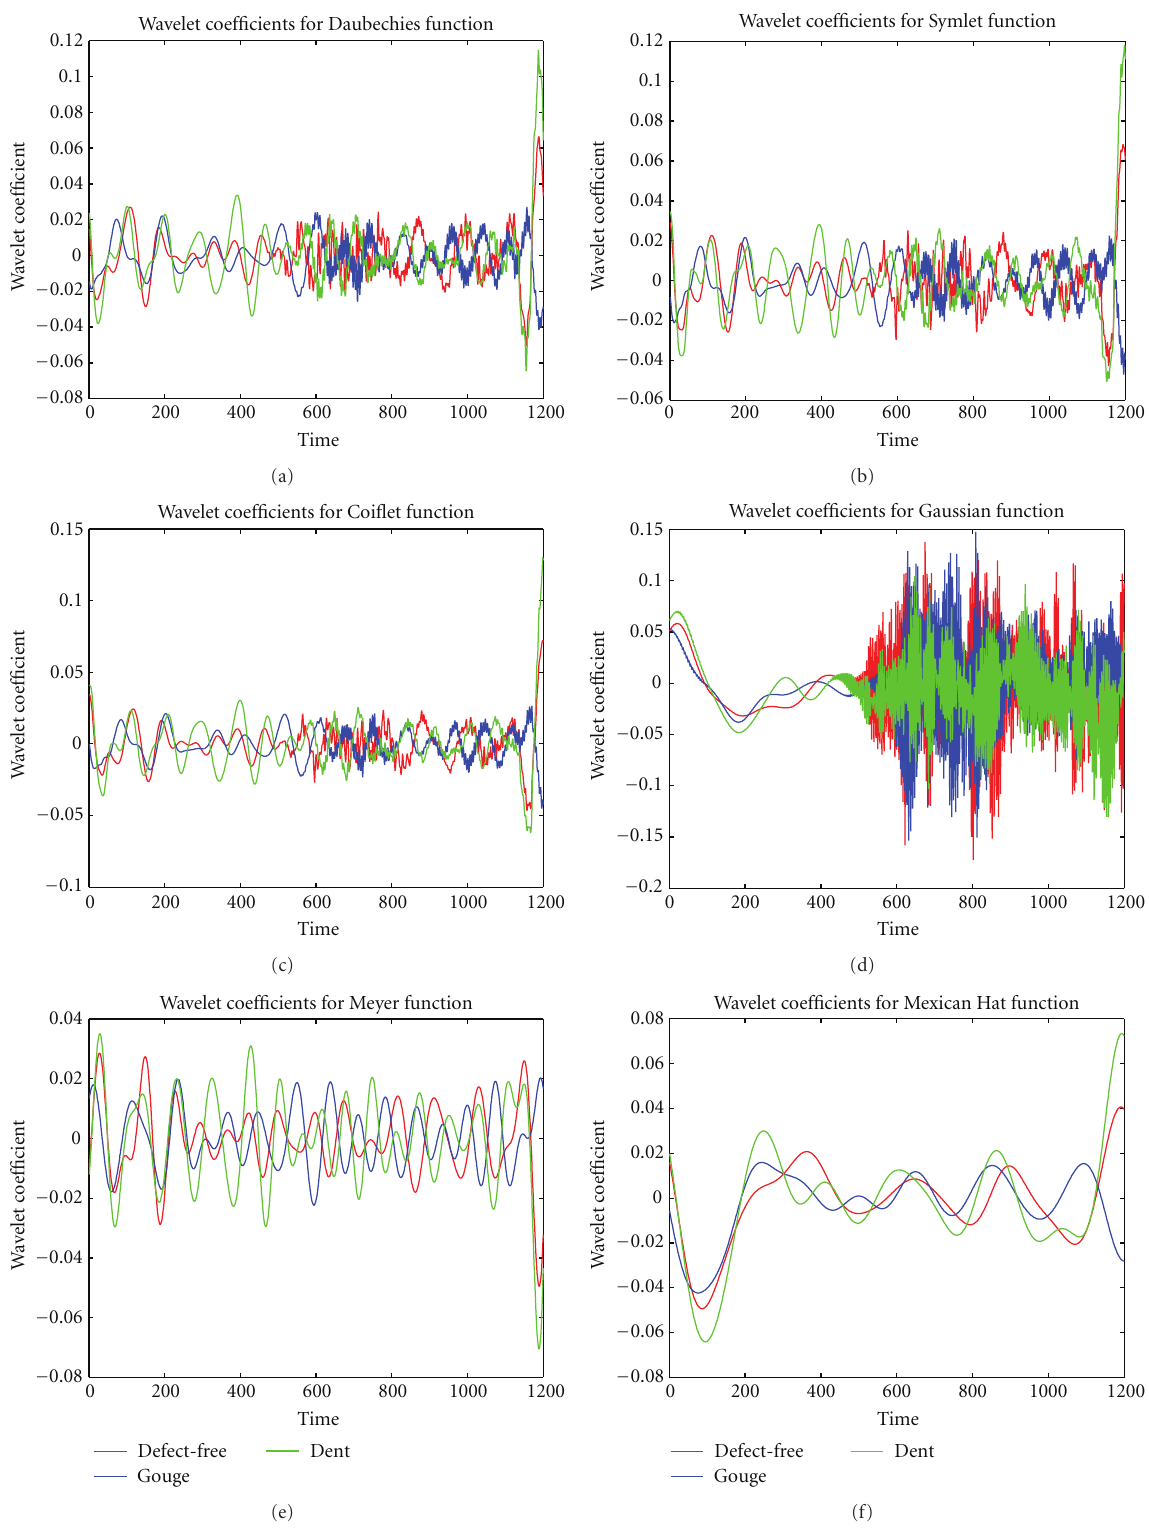
Figure 6: Comparison of experimental signals for defective and defect-free pipes using di ff erent wavelet functions with a scale of 64 for (a) db4, (b) sym4, (c) coif2, (d) gauss1, (e) Meyer, and (f) Mexican hat wavelet